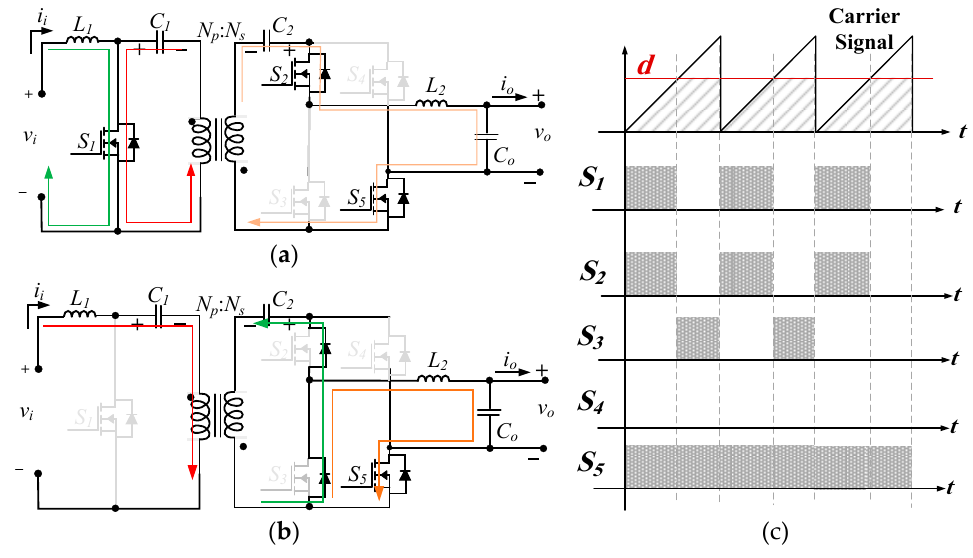
Figure 17. Cuk SM positive half-cycle’s currents during Mode 3: ( a ) St ac1 , ( b ) St ac2, and ( c ) modulation scheme.